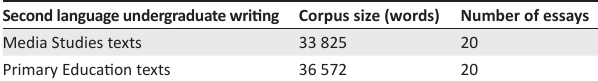
TABLE 1: Data used and size of the